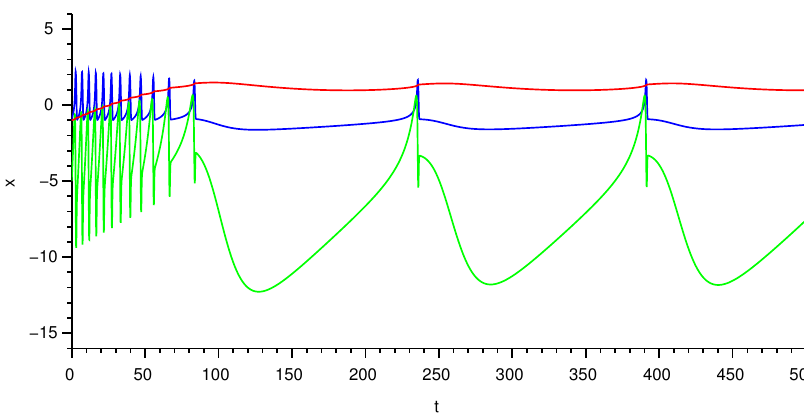
Figure 2. State of the leader neuron. Blue line: x 0,1 , green line: x 0,2 , red line: x 0,3 .